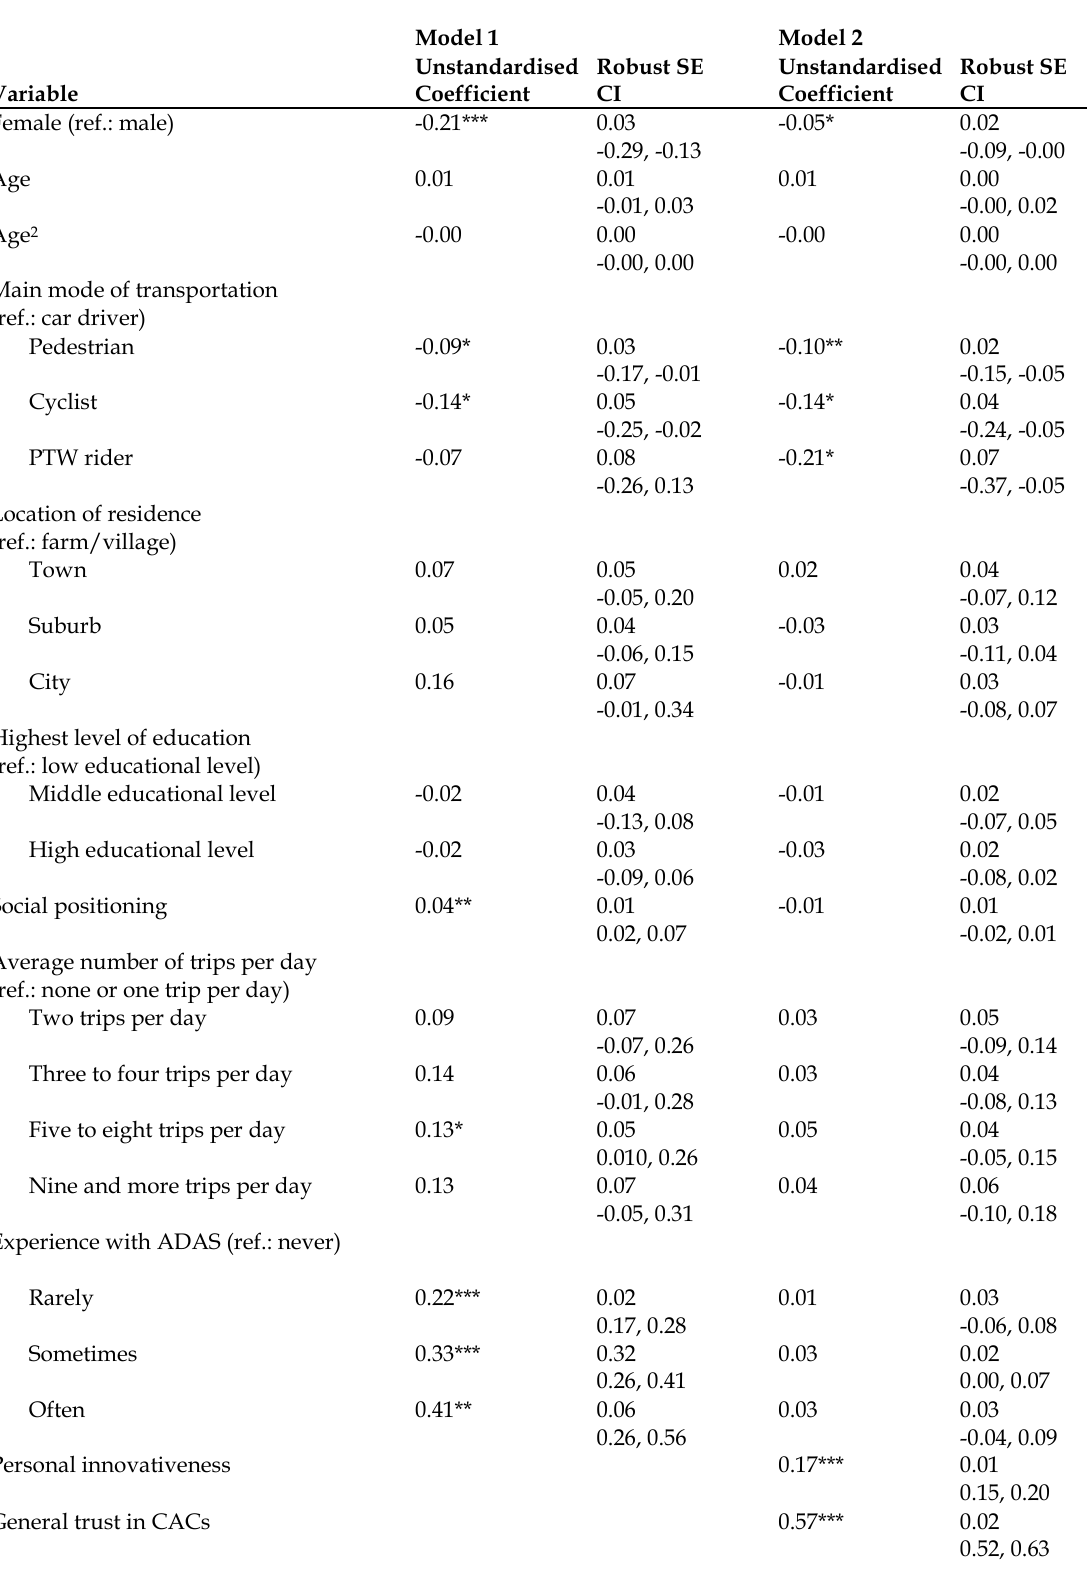
Table 6. Linear regression models with road user acceptance of CACs as the dependent variable; use of robust standard errors, clustered by country (i.e. standard errors (SE), confidence intervals